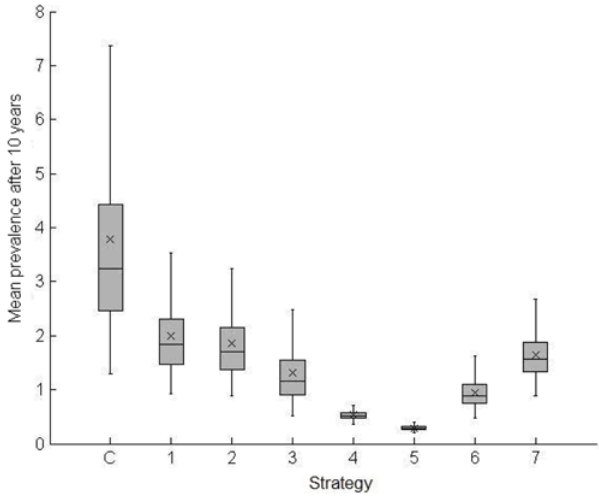
Figure 4. Results of the uncertainty analysis. Boxplots of the average prevalence after 10 years (%). For each set of parameters of the sample generated by the Latin Hypercube Sampling method and each strategy, we performed 600 runs of the model and computed the average prevalence after 10 years. Each boxplot represents the median, the first and third quartiles (Q1 and Q3), the mean and the maximum and minimum values which are in the range [Q1 2 1.5 IQR, Q3 + 1.5 IQR] with IQR equal to the inter-quartile range (Q3-Q1).